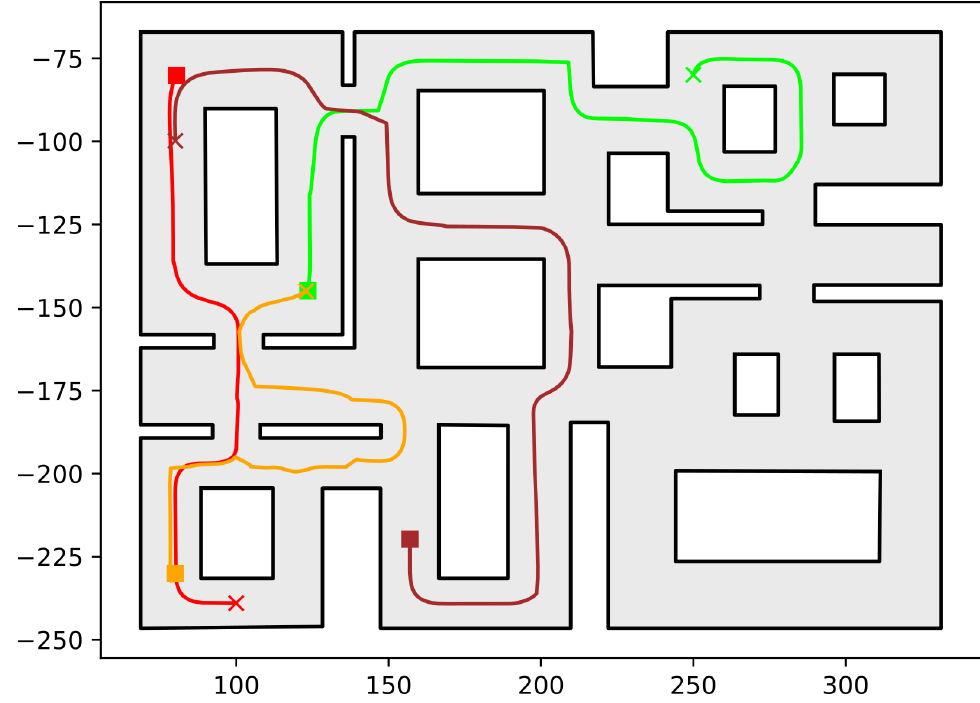
Figure 6. Executed trajectories of the four-robot case. Squares indicate initial positions, whereas the corresponding goal positions are depicted using crosses. Robot #1 (red); Robot #2 (green); Robot #3 (dark red); Robot #4 (orange). The axes units are in